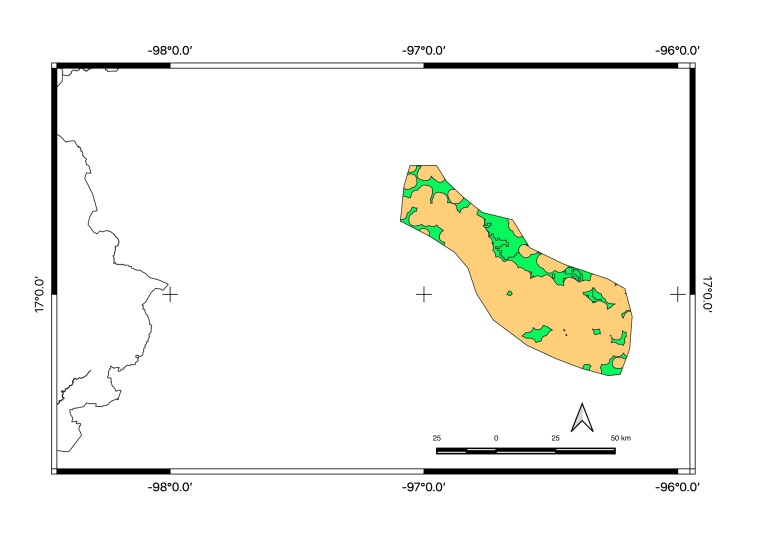
Habitat quality across the distribution of Brachypelma
schroederi Rudloff, 2008. Low quality habitat areas (LQH) in orange and high quality habitat areas (HQH) in green (for estimation details, see formula in Methods).